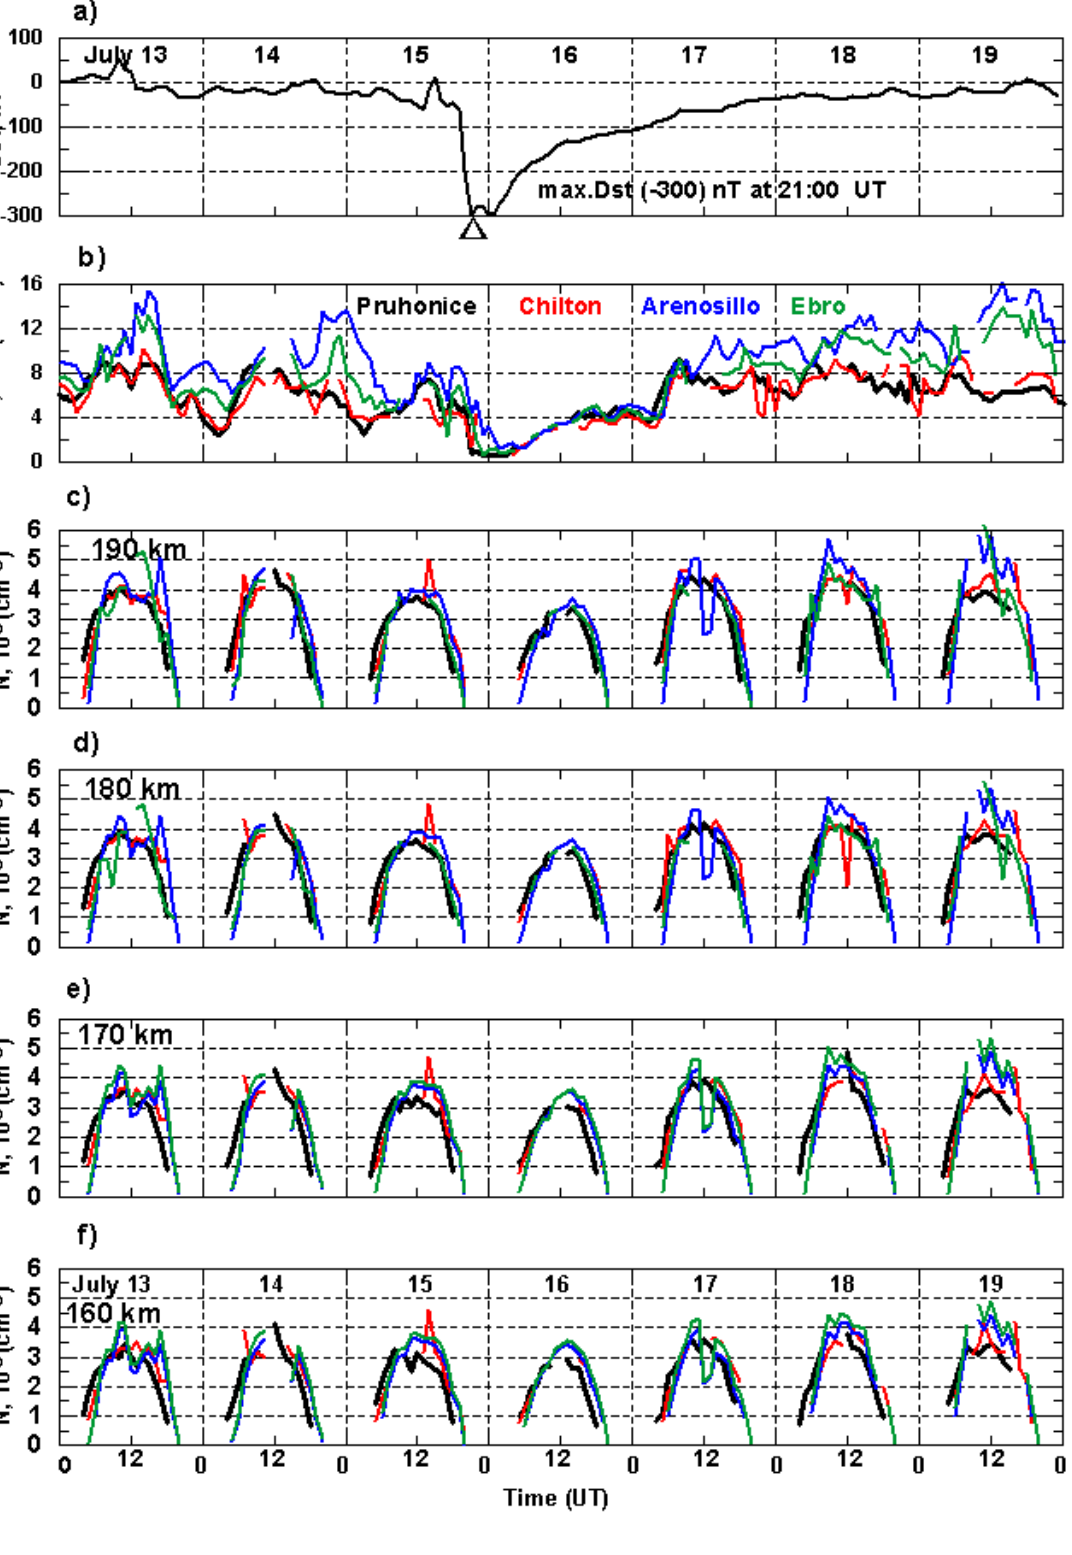
Fig. 7. Results for the July 2000 super storm: (a) hourly D st indices, (b) hourly values of Nm F2 for Chilton, Pruhonice, Ebro and Arenosillo, (c–f) daytime electron density at 190, 180, 170 and 160km, respectively, for all stations. Time is in